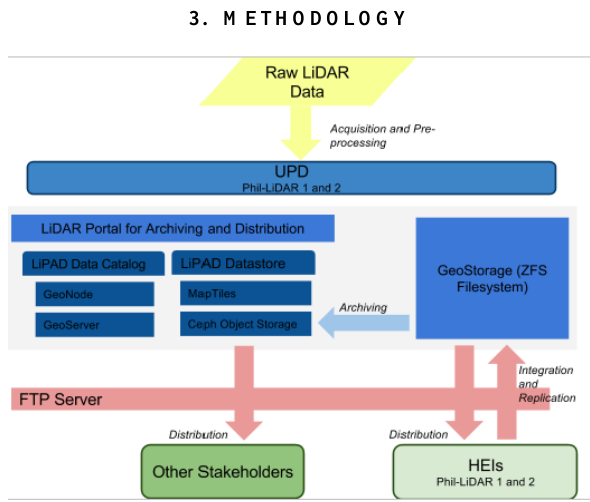
Figure 3. Conceptual Framework of Data Distribution and